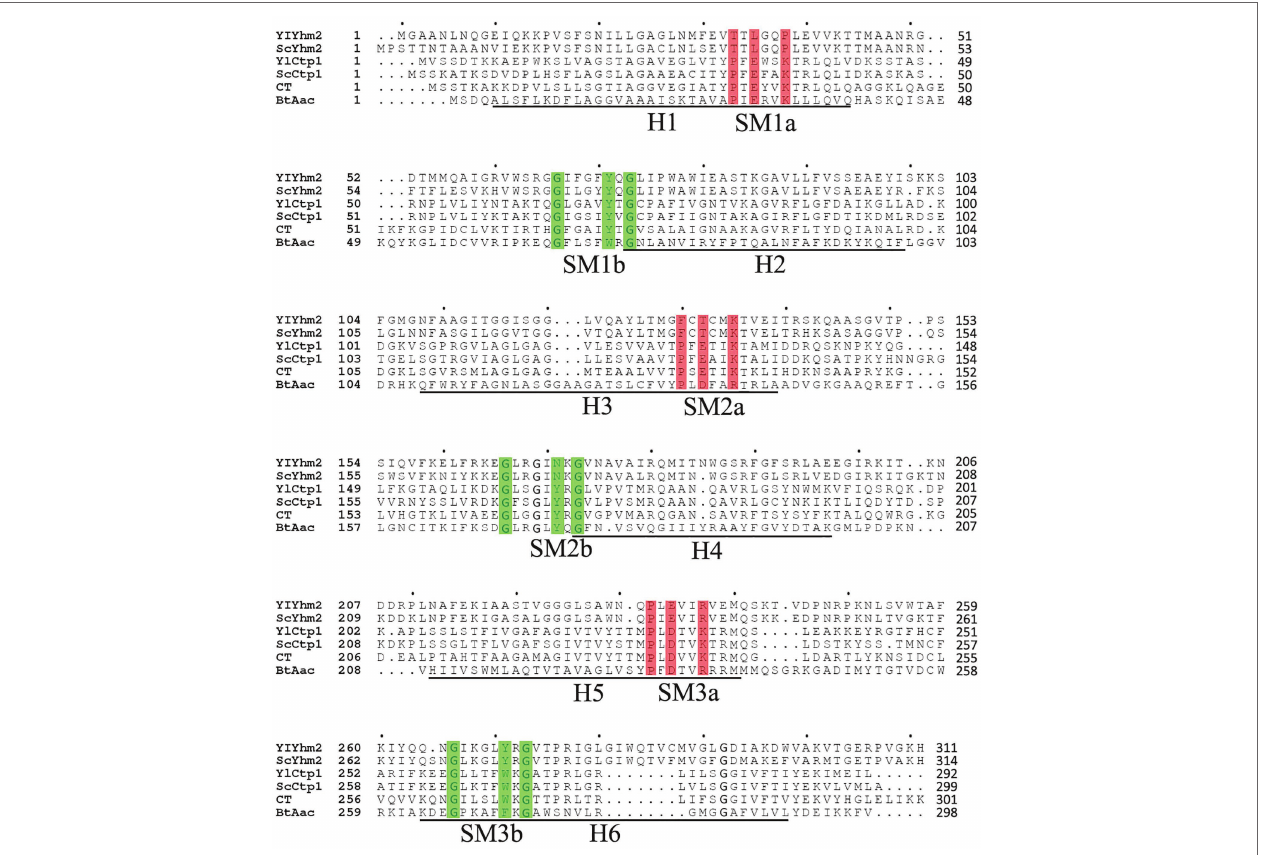
FIGURE 1 | Amino acid sequences of CT were aligned with its homologs in Saccharomyces cerevisiae , Yarrowia lipolytica , and the sequences of ADP/ATP carrier. The sequences of six transmembrane helices (H1–H6) from the ADP/ATP carrier are underlined. Odd transmembrane helix in red part a and even transmembrane helix in green part b represent 3-fold repeated signature motif (SM) characteristic of the MC family proteins. YlYhm2 and YlCtp1 were citrate transporters from Y. lipolytica ; ScYhm2 and ScCtp1 were citrate transporters from S. cerevisiae , and BtAac1 was the ADP/ATP carrier from Bos taurus , which was the member of MC family whose three-dimensional structures have been determined.